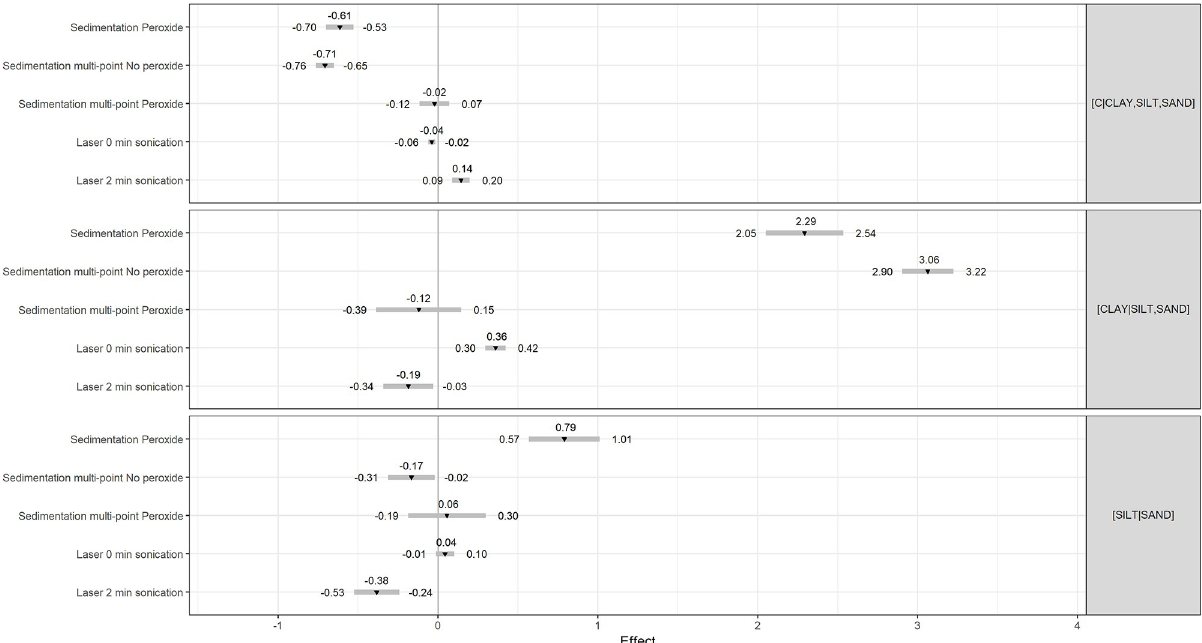
Fig 4. Mean differences (p � 0.025) in textural balances between several methodologies against the reference 2-point 2-h sedimentation method without pre-treatment.